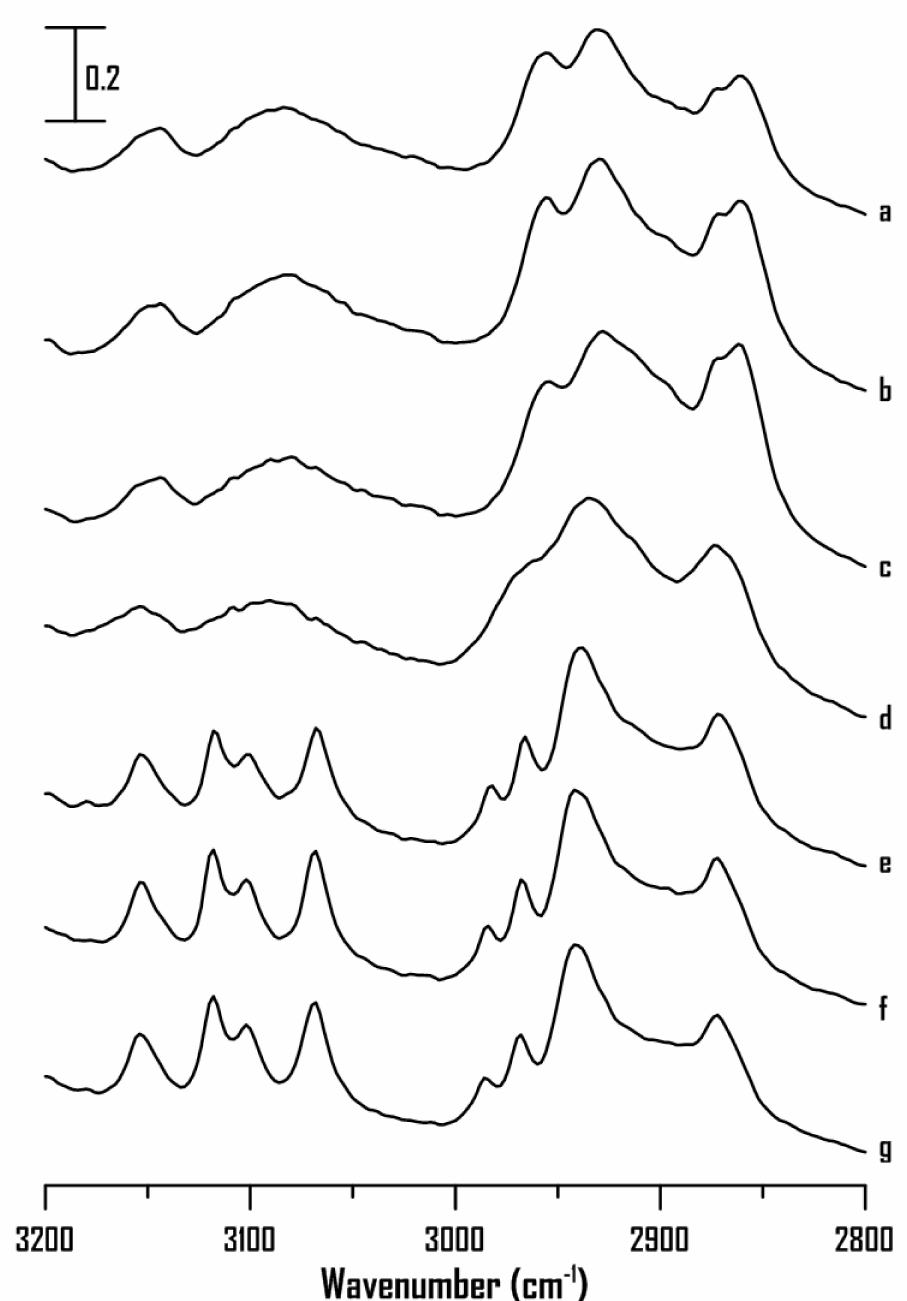
Figure 9. IR spectra of the [HMIM]Br-PEO mixture containing 80 wt% [HMIM]Br at ( a ) ambient pressure and ( b ) 0.4, ( c ) 0.7, ( d ) 1.1, ( e ) 1.5, ( f ) 1.8, and ( g ) 2.5